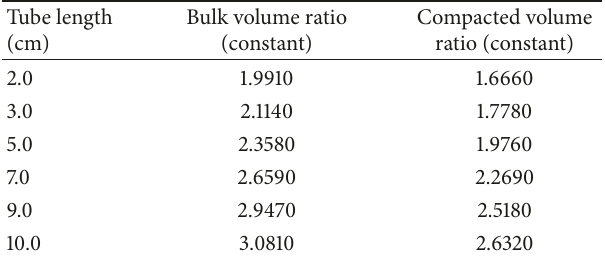
Figure 6: Heat-transfer characteristics of the reactor. Table 1: Bulk and compacted volume ratios as a function of tube